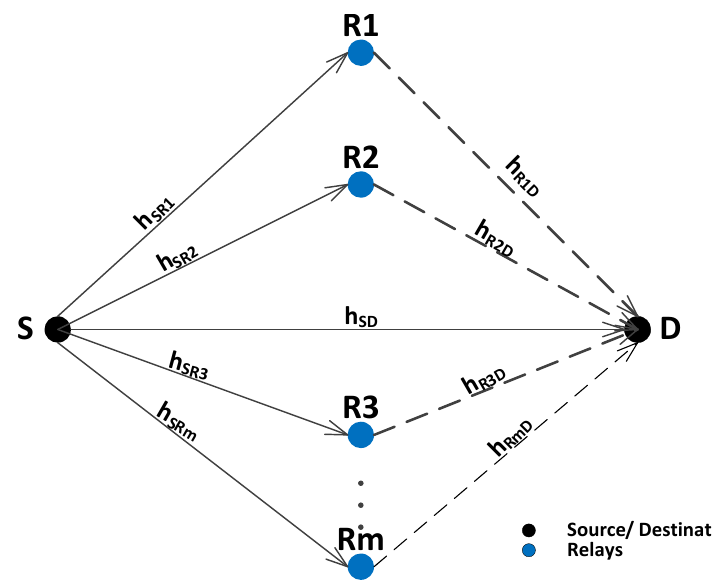
Figure 1. System